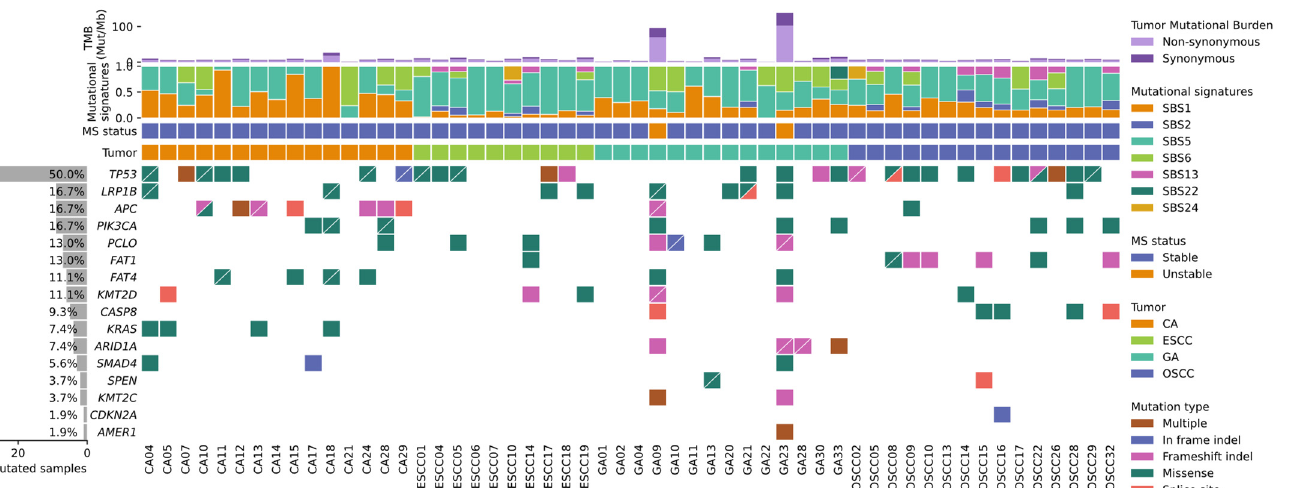
Figure 5. Swarm plot of total neoantigen bound across multiple cancer types. Every point on the swarm plot represents a sample. Red indicates samples with presence of AA signature (SBS22)